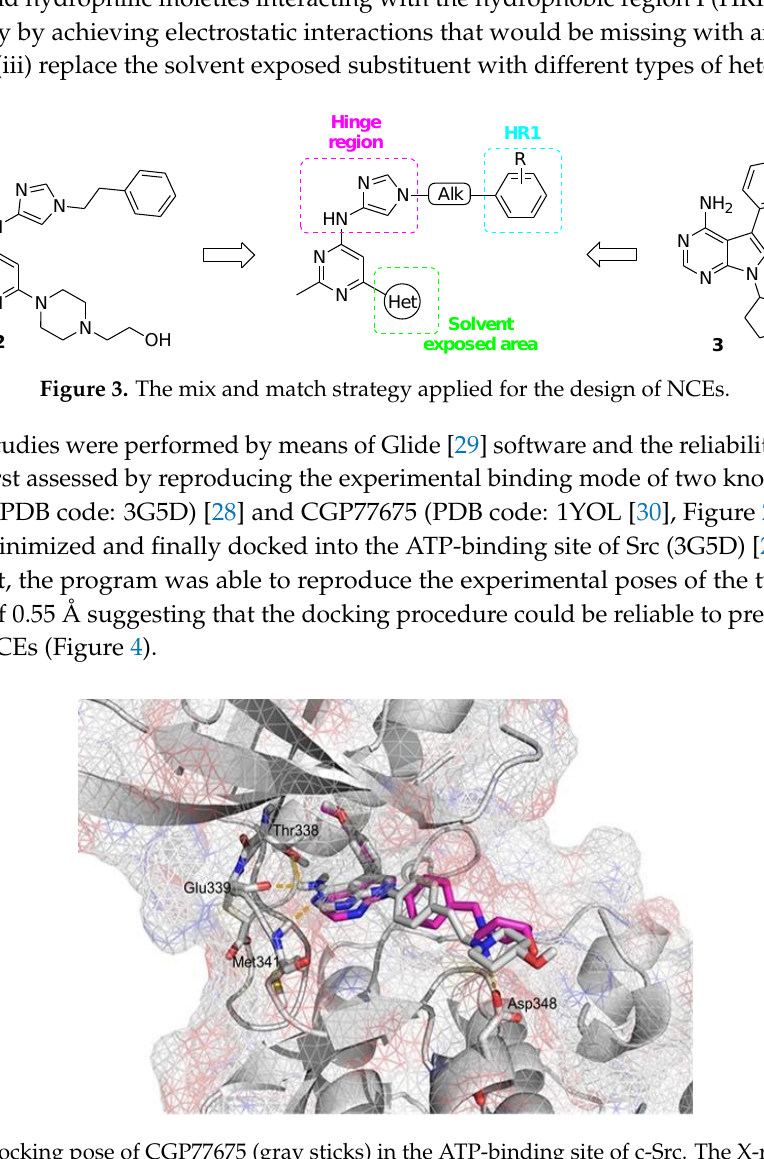
Figure 4. Docking pose of CGP77675 (gray sticks) in the ATP-binding site of c-Src. The X-ray structure has been overlapped for reference (magenta sticks). For sake of clarity, only a few residues are displayed in gray sticks. Hydrogen bonds are shown as yellow dashes.